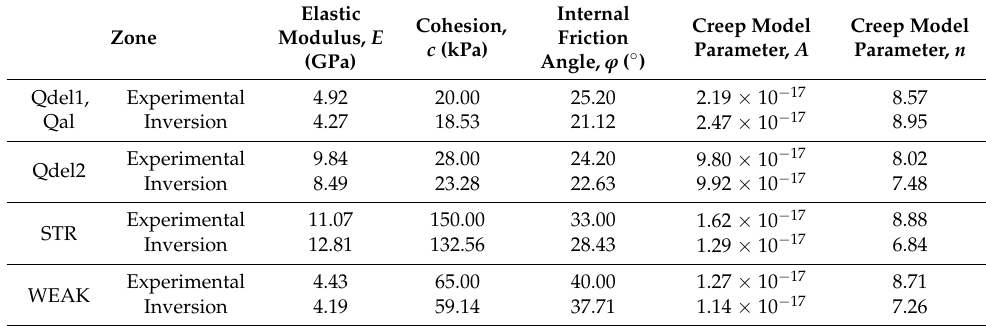
Table 2. The identified parameters of each